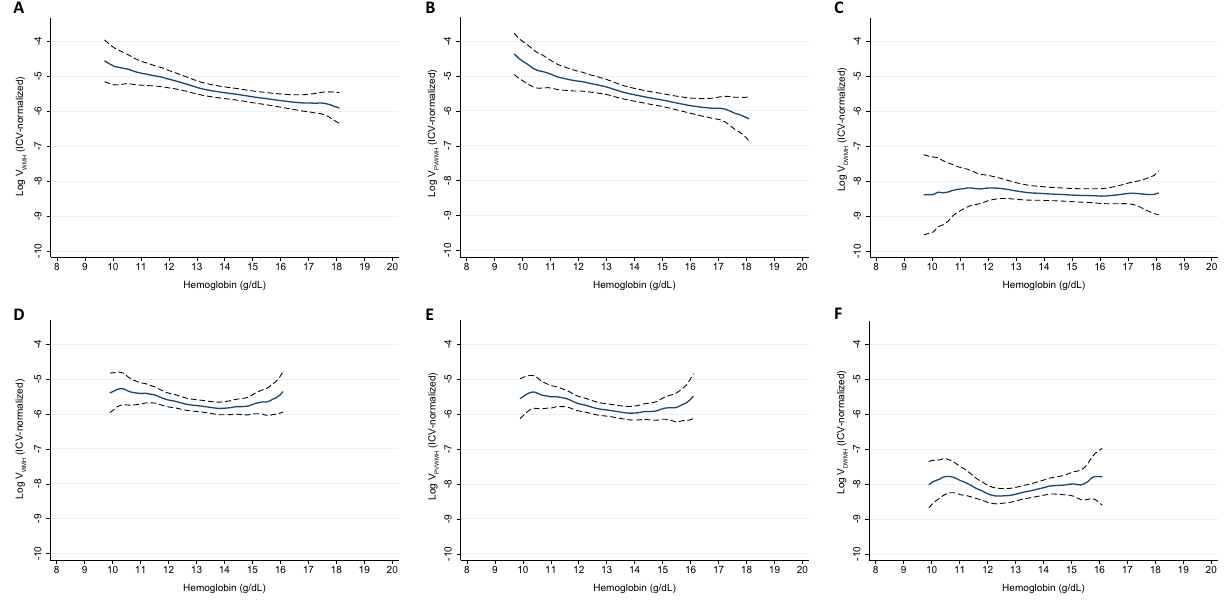
Figure 1. Serum free hemoglobin level and volumes of white matter hyperintensities. ICV intracranial volume V WMH volume of total white matter hyperintensity, V PVWMH volume of periventricular white matter hyperintensity, V DWMH volume of deep white matter hyperintensity. Restricted cubic spline analyses for the association of serum free hemoglobin level with volumes of white matter hyperintensities. Volumes of total ( A ), periventricular ( B ), and deep ( C ) white matter hyperintensities and serum free hemoglobin level in male older adults, and volumes of total ( D ), periventricular ( E ), and deep ( F ) white matter hyperintensities and serum free hemoglobin level in female older adults. All the volumes were normalized to individuals’ intracranial volumes and